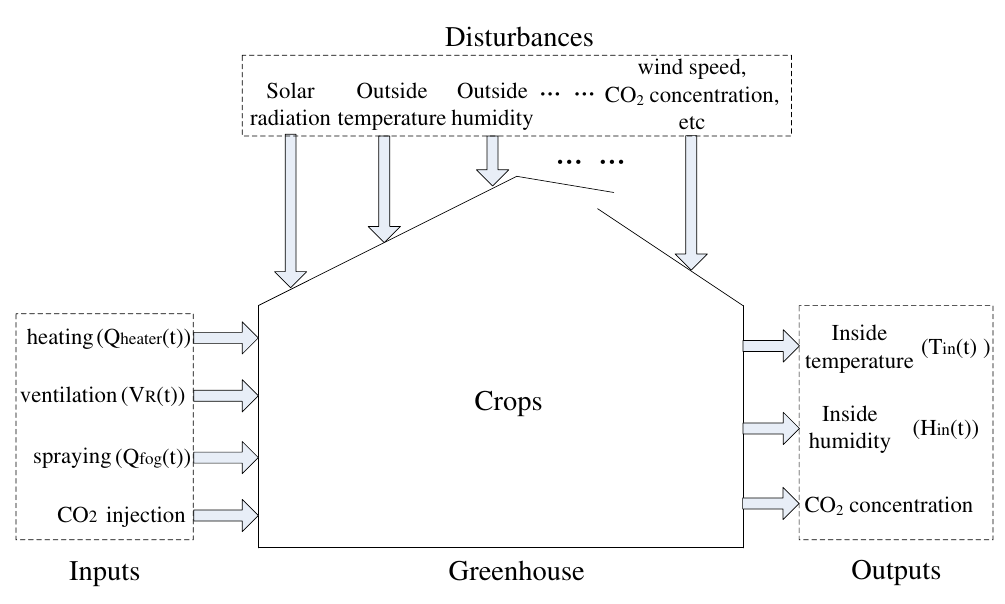
Figure 1. Greenhouse climate dynamic